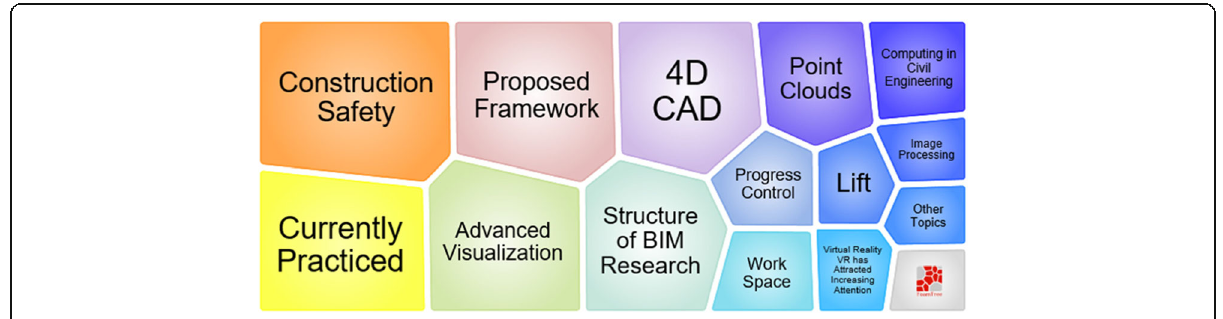
Fig. 10 Foam tree view of keywords in topic 2